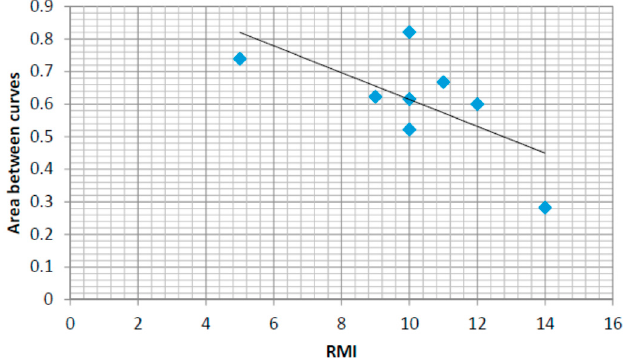
Figure 18. RMI and anterior/posterior vs. linear area between curves.